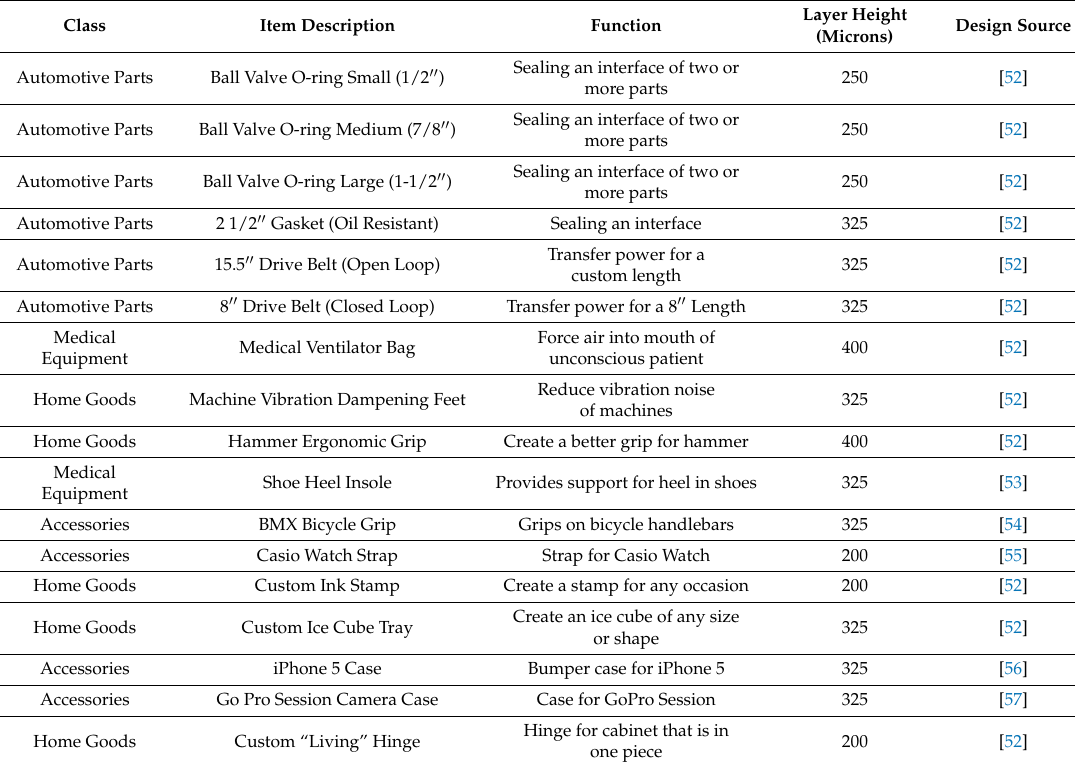
Table 2. Products for flexible material printing: name, function,